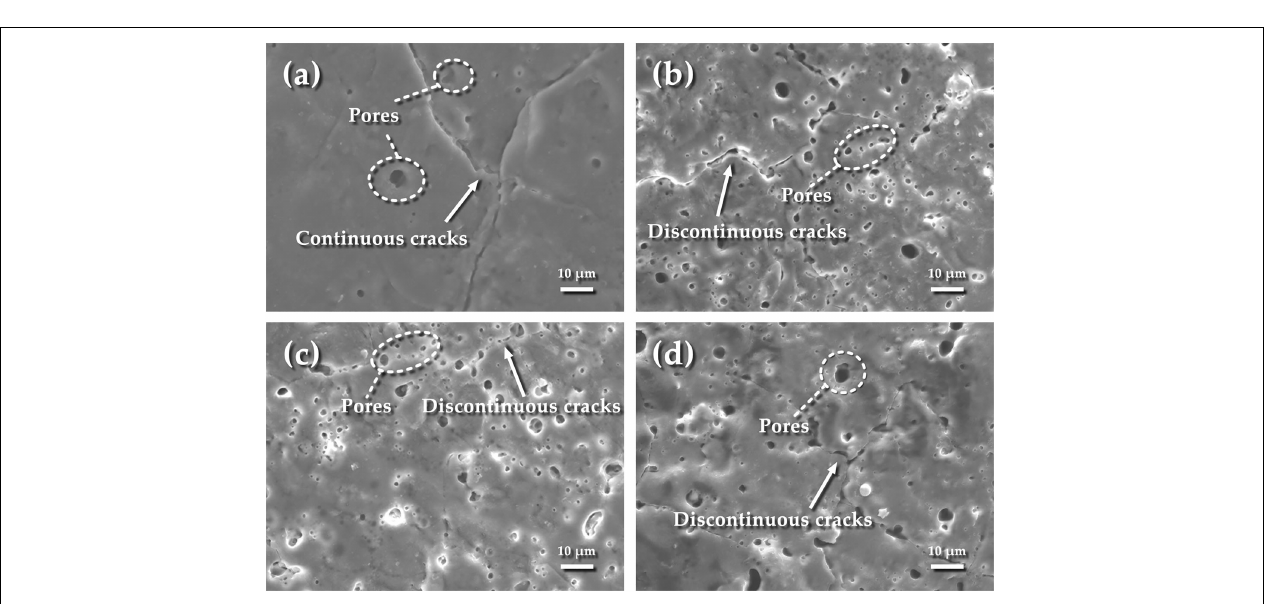
FIGURE 2 | X-ray diffraction patterns of the MAO coatings fabricated under the different current modes.